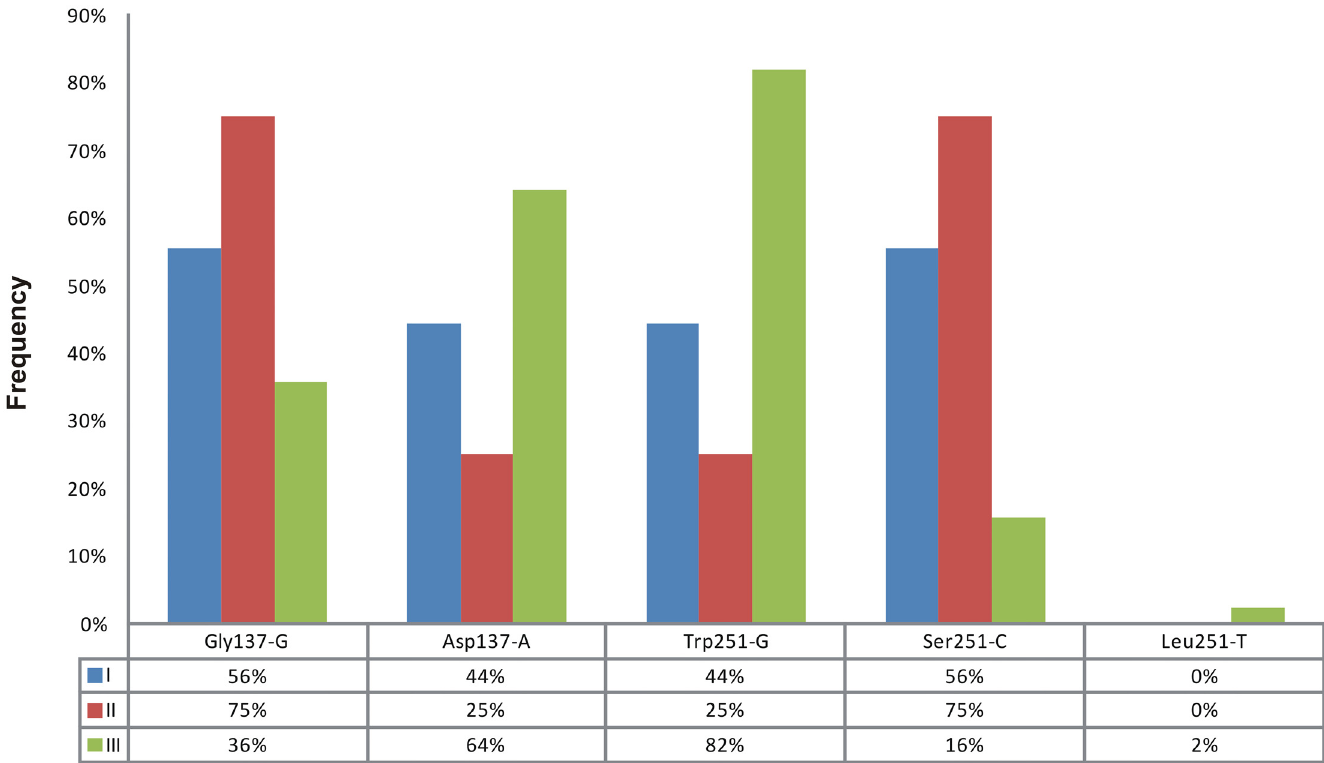
Fig 4. Frequencies of polymorphic nucleotides related to the determination of susceptibility and resistance in the codons 137 and 251 of the Ch α E7 sequence. The structure in groups I, II and III (K = 3) was analyzed. Codons were named for the encoded amino acid, Ch α E7 sequence position (amino acid number) and the nucleotide substitution of that codon (Gly137-G, Asp137-A, Trp251-G, Leu251-T and Ser251-C).